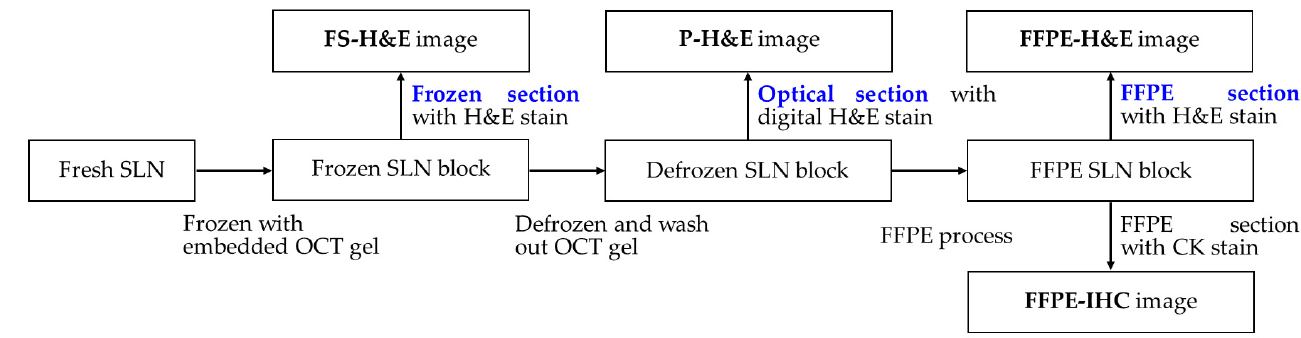
Figure 1. Processing flow of an ex vivo SLN for the production of FS-H&E, p-H&E, FFPE-H&E, and FFPE-IHC images.